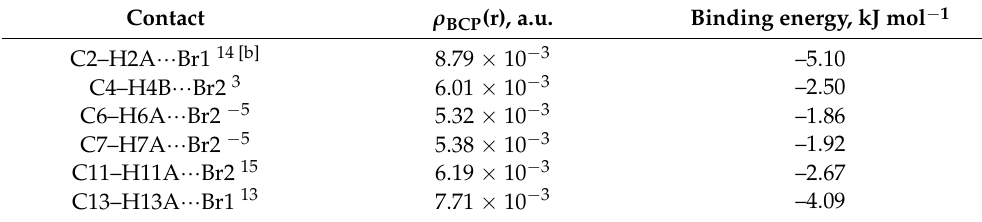
Table 4. Electron density at the H ··· Br BCP and respective binding energies for selected intermolecular contacts in the structure 3 [a] .